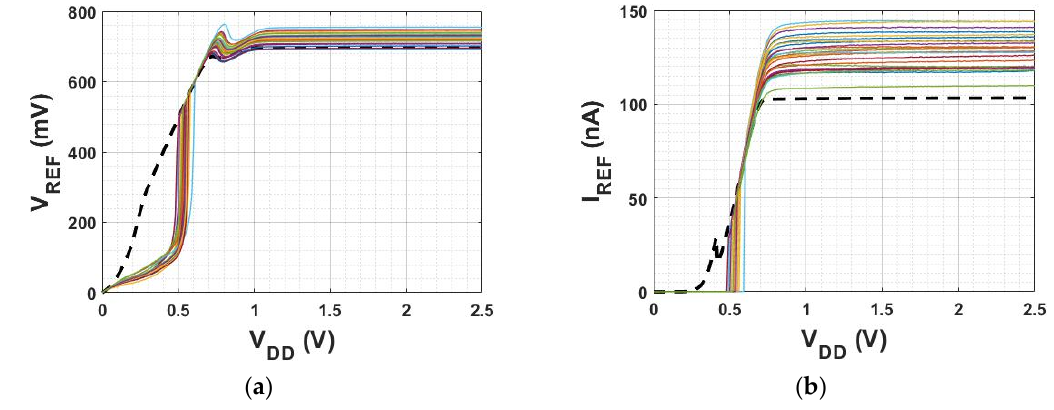
Figure 20. Supply voltage variation of ( a ) V REF and ( b ) I REF . Table 8. Summary of results.